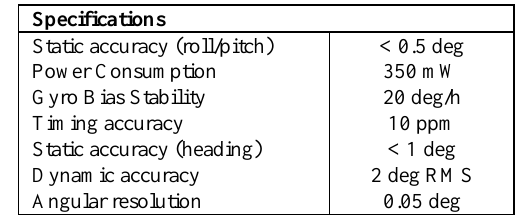
Table 3. Specification of Xsense MTi series G inertial platform